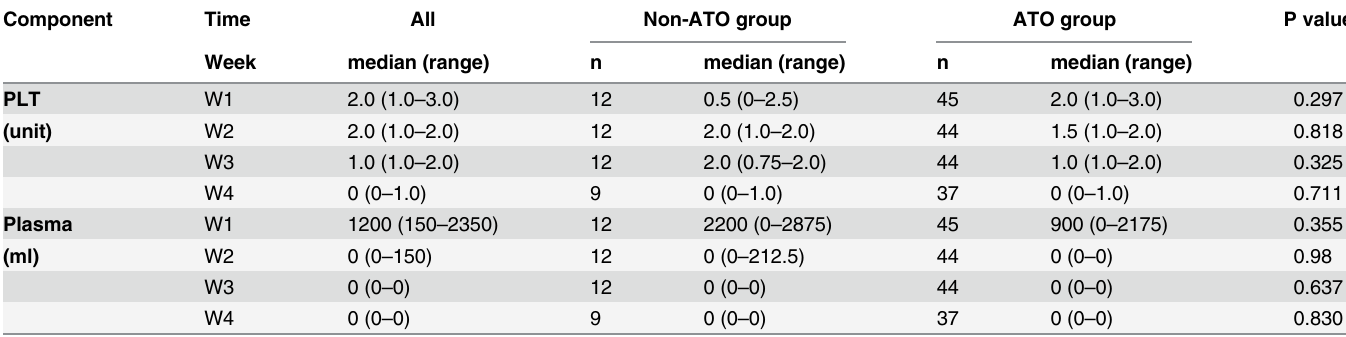
Table 5. Compared analysis of consumption of component blood between non-ATO group and ATO group. Component